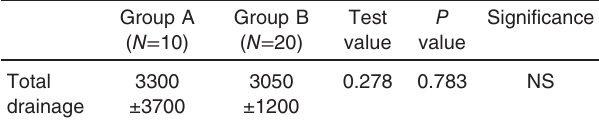
Table 4 Total drainage of the pleural fluid in groups A and